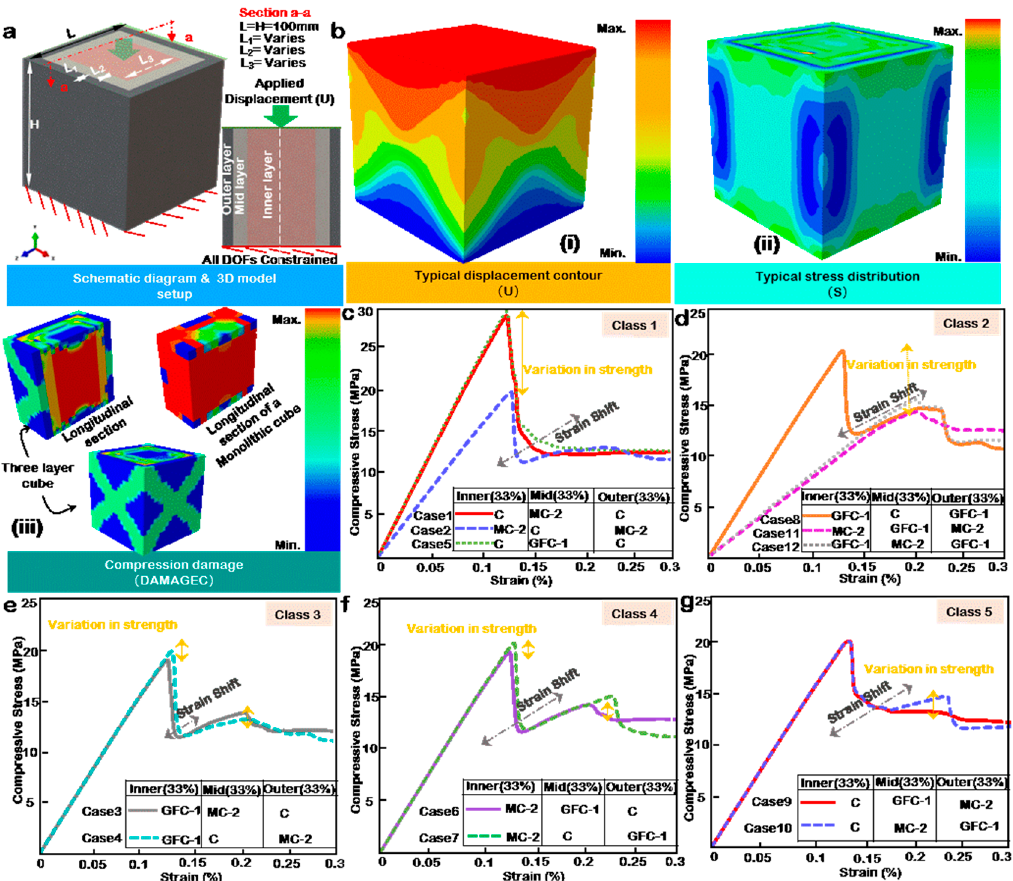
Figure 5. ( a ) Schematic diagram of the three-layer configuration, showing the applied displacement and boundary condition. ( b ) Three-layer configuration simulation contour plot of (i) Displacement, (ii) Misses stress, and (iii) Compression damage. Numerical stress–strain curve for ( c ) Class 1, ( d ) Class 2, ( e ) Class 3, ( f ) Class 4, and ( g ) Class 5. Table 6. Three-material multi-layer concrete case table. Inner (Layer Volume: 33.333%